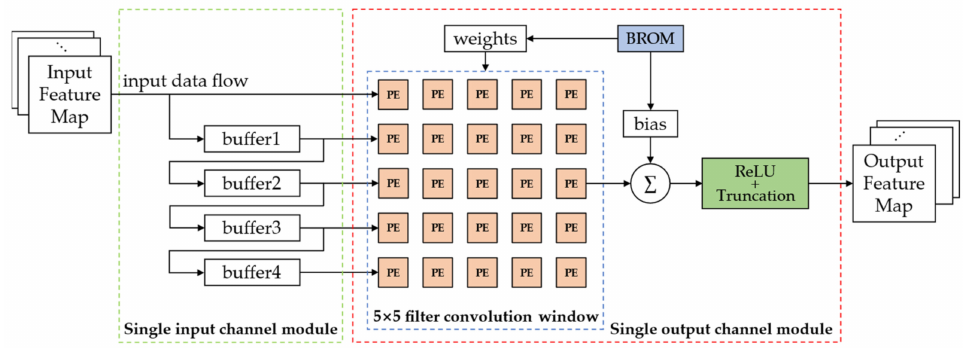
Figure 7. The shift-based convolutional computation module.